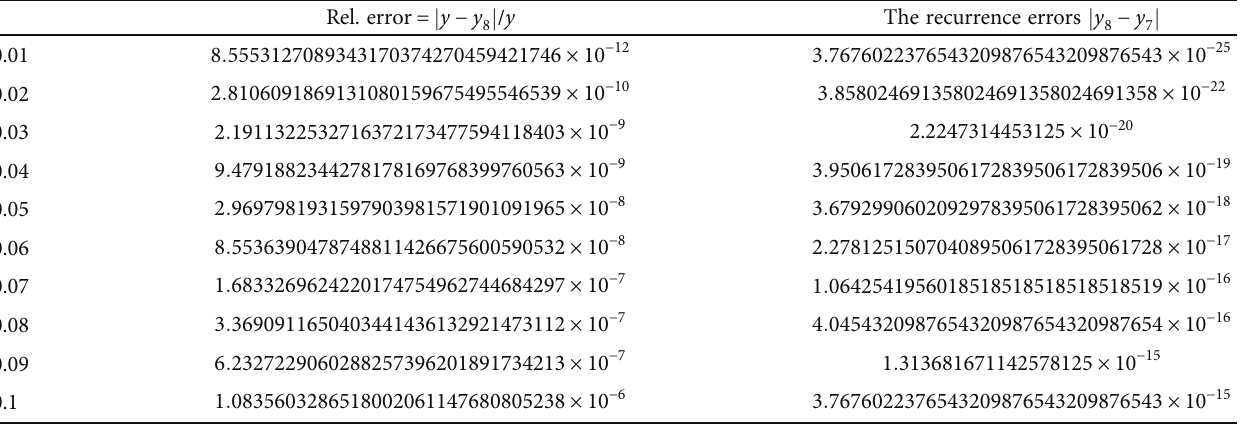
Table 9: Relative error = j y − y Example 2.